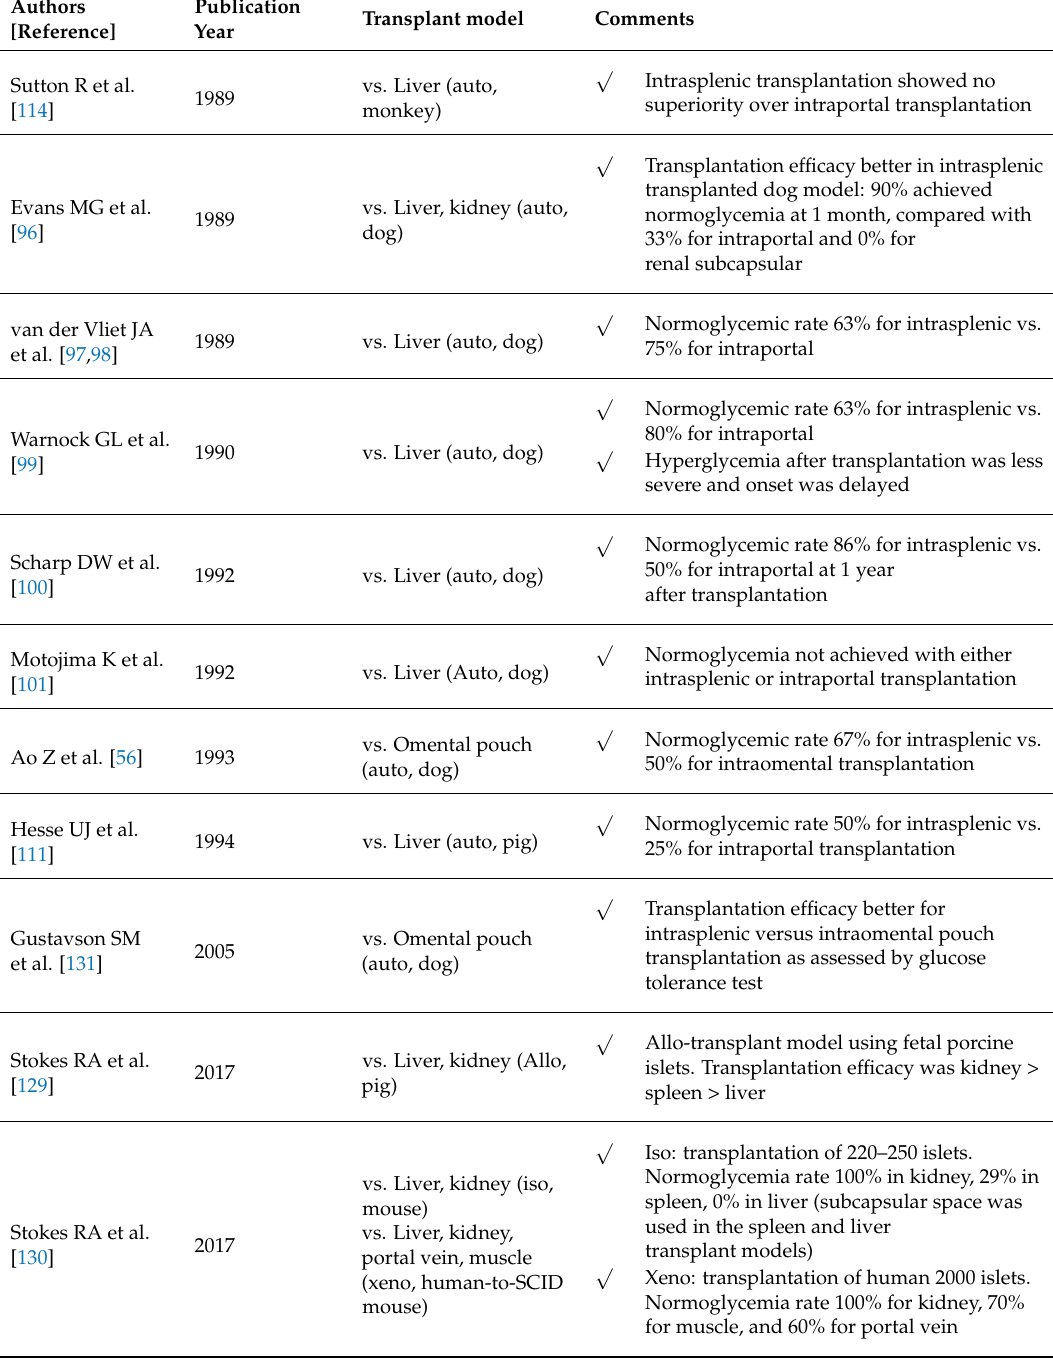
Table 3. Efficacy of intrasplenic islet